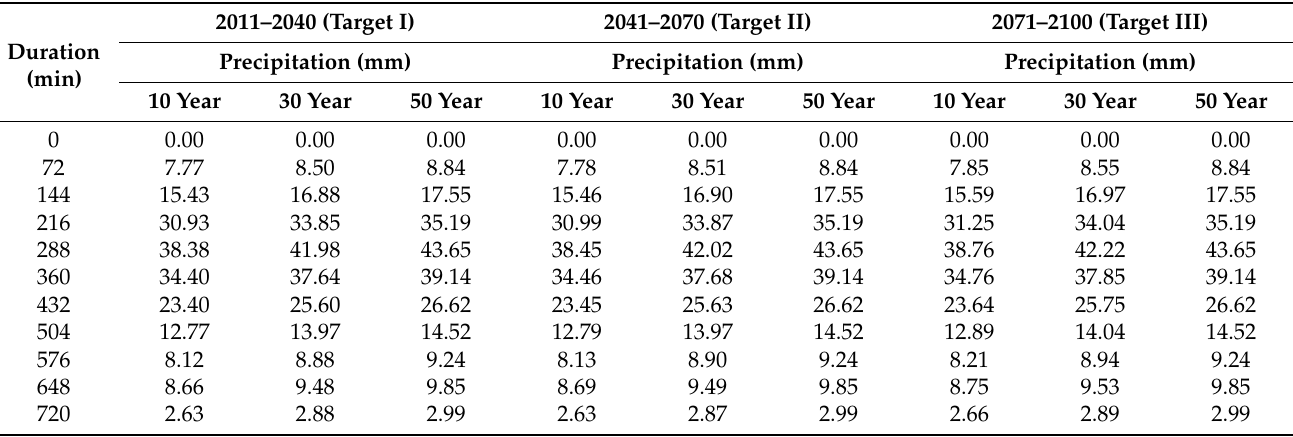
Table 6. Predicted probable precipitation for three target periods for the duration of 12 h in Changwon City